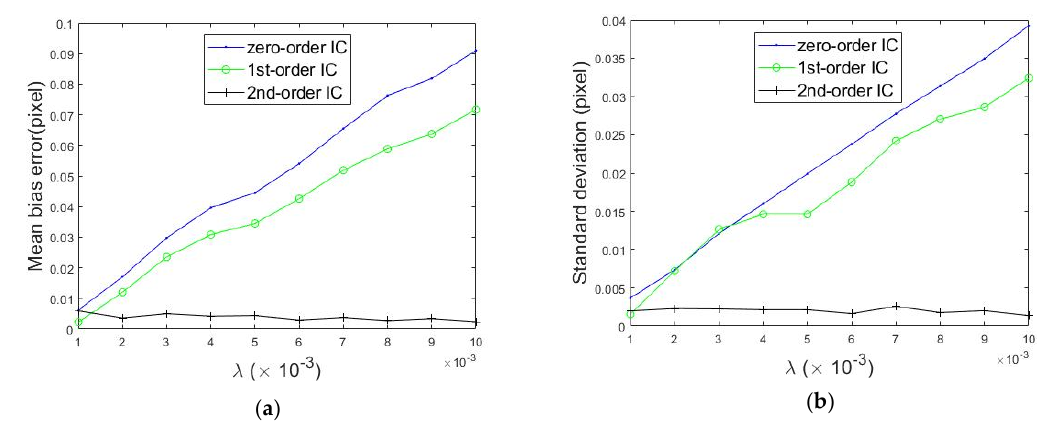
Figure 10. Calculated errors of the non-uniform deformations compared to the set values. ( a ) Mean bias error; ( b ) standard deviation; and ( c,d ) enlarged views of the red dotted areas in ( a ) and ( b ), respectively.